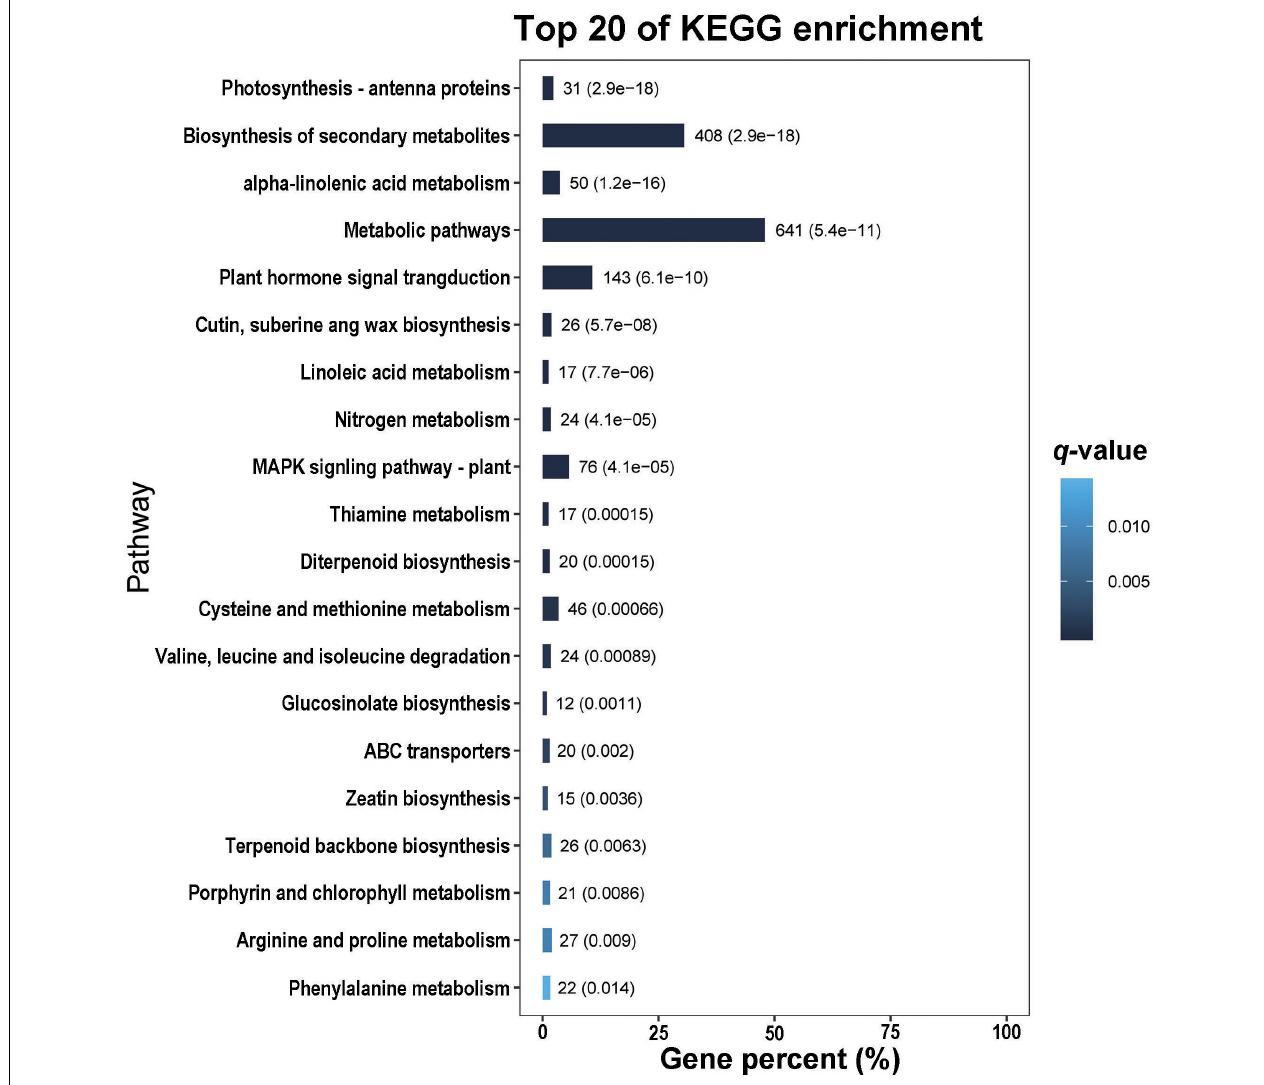
FIGURE 2 | The top 20 pathways of differentially expressed genes (DEGs) identified in Gossypium barbadense leaves after Helicoverpa armigera infestation.